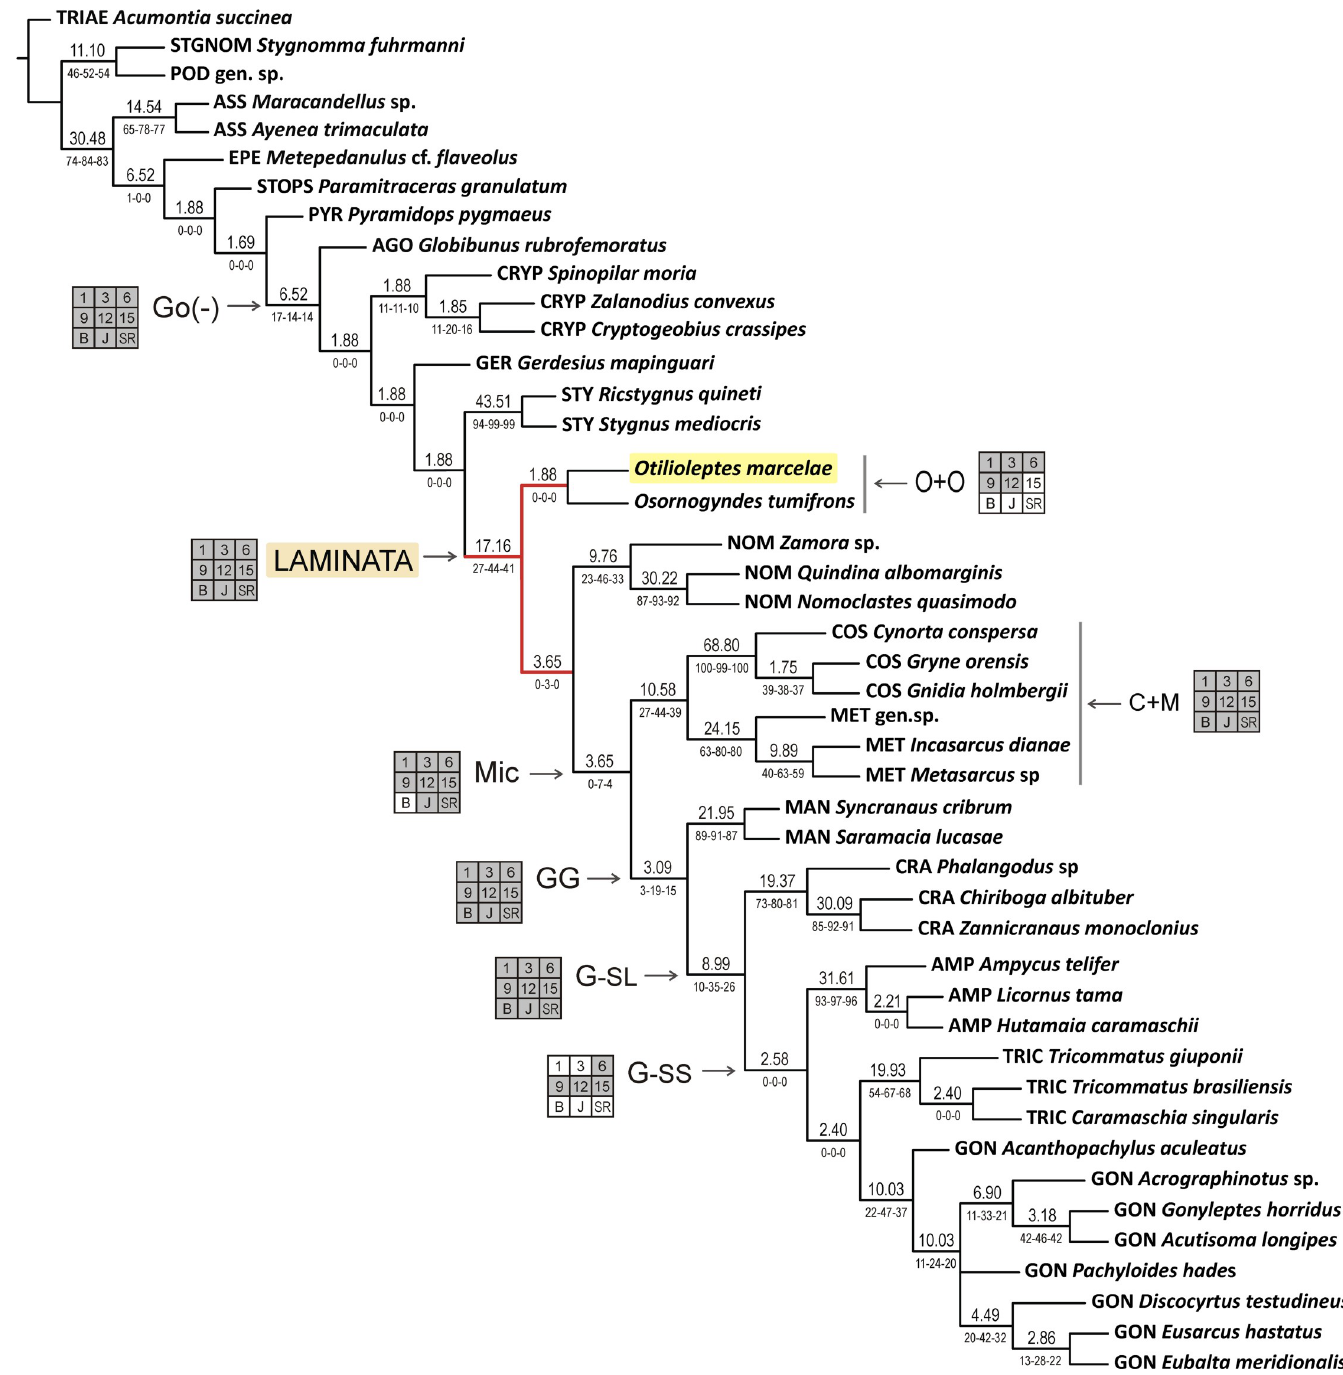
Fig 2. Cladistic relationships of Gonyleptoidea and placement of Otiloleptes marcelae gen. nov., sp. nov. Single most parsimonious tree obtained with implied weights (IW), k = 6 (Ci: 0.30, Ri: 0.59, tree length: 510 steps). Number above each branch indicates Bremer support; below, values of bootstrap, jackknife and symmetric resample (B-J-SR). Grid (‘Navajo rug’) beside a clade summarizes whether it is retrieved (grey cell) or not (white cell) in selected treatments (k = 1, 3, 6, 9, 12, 15, B, J, SR resamplings of the k = 6 tree). In red: sector of K&V [25] hypothesis where Otilioleptes is incorporated (basal in Laminata).